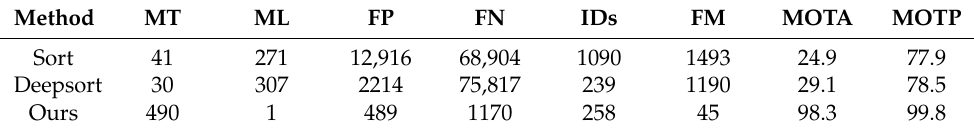
Table 8. Comparison of tracking metrics on MOT16 dataset and deepsort algorithm (continued).